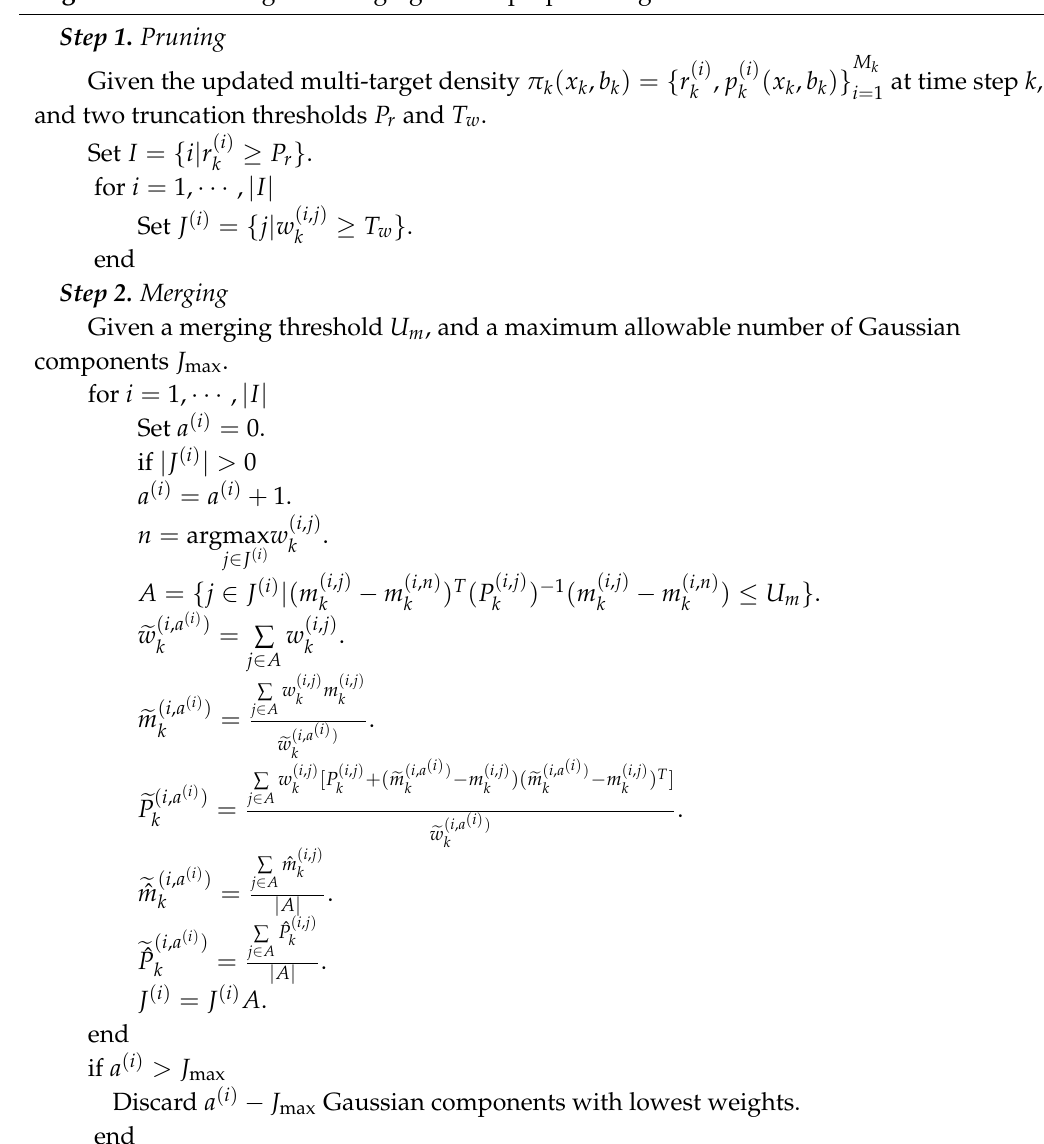
Algorithm 1. Pruning and merging for the proposed algorithm. Step 1 .